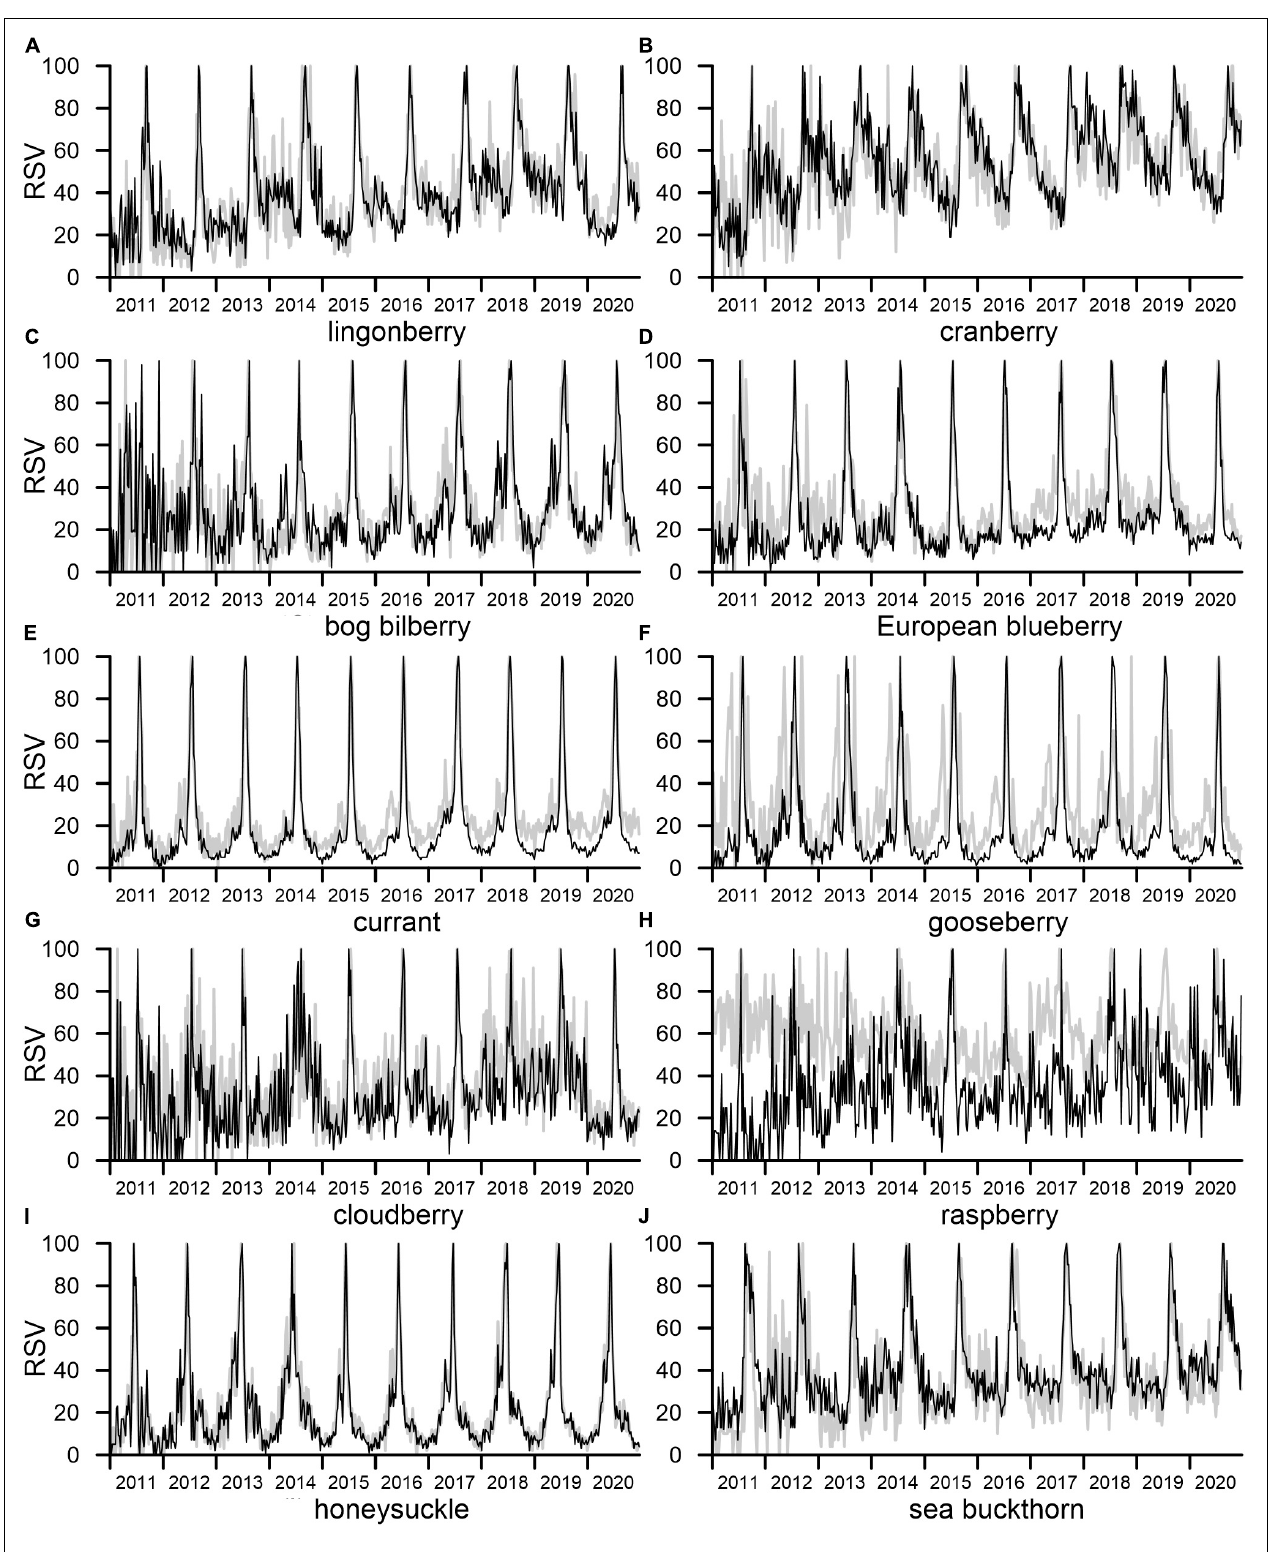
FIGURE 1 | Weekly relative search volume (RSV) for each year of (A) lingonberry, (B) cranberry, (C) bog bilberry, (D) European blueberry, (E) currant, (F) gooseberry, (G) cloudberry, (H) raspberry, (I) honeysuckle, and (J) sea buckthorn from 2011 to 2020 across Russia. Black and gray lines indicate results of “search topic” and “search terms (Russian words),”